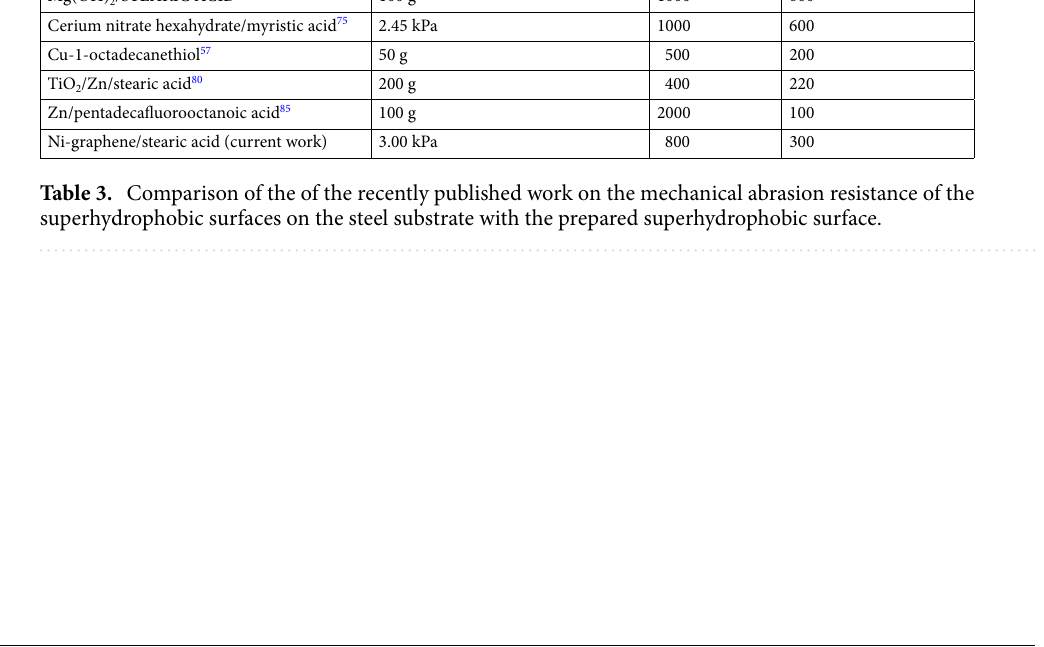
Superhydrophobic